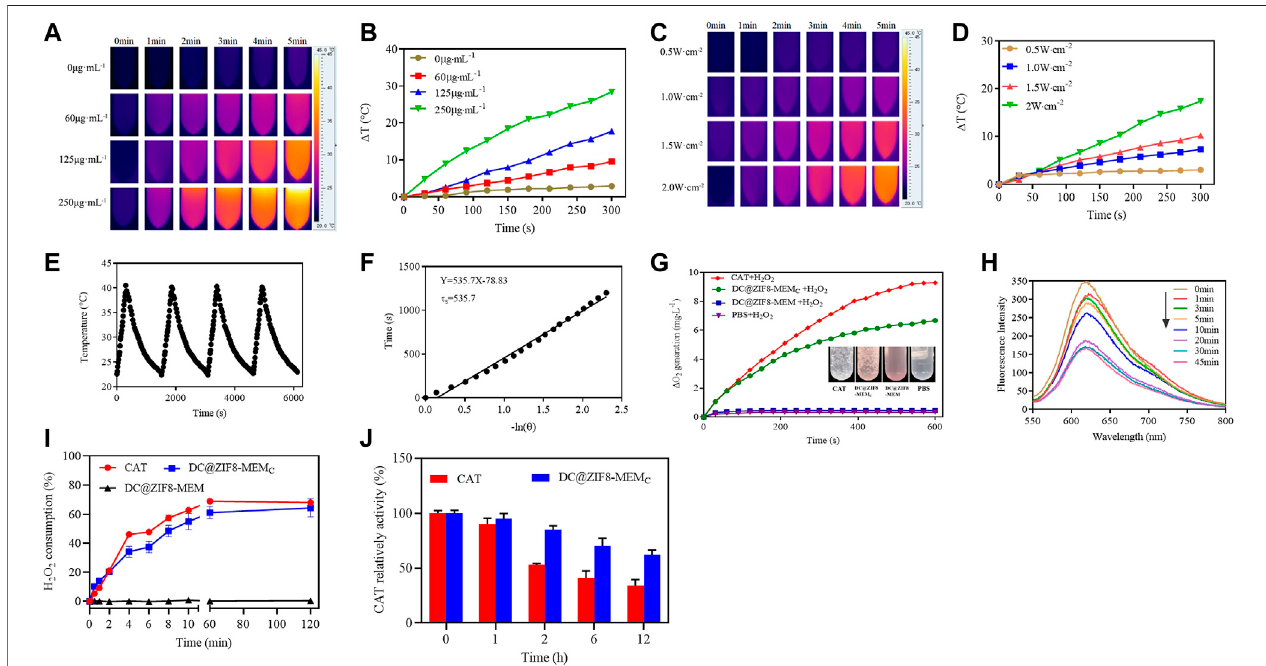
FIGURE3| PhotothermalimagesofDC@ZIF8-MEM C withvariousconcentrationsbyFLIR (A) .TemperaturecurvesbychangingconcentrationofDC@ZIF8-MEM C with808 nm nearinfrared (NIR) at 2 W · cm − 2 for5 min (B) .Photothermalimages ofDC@ZIF8-MEM C withvarious laserpower densities byFLIR (C) .Temperaturecurves ofDC@ZIF8-MEM C bychangingthelaserpowerdensity (D) .TemperaturevariationsofDC@ZIF8-MEM C byrepeatingon/off(2 W cm − 2 ) (E) .Temperature fi ttingcurveof DC@ZIF8-MEM C (F) . The O 2 -generating behavior of DC@ZIF8-MEM C , DC@ZIF8-MEM, PBS, and free CAT solution in the presence of H 2 O 2 . Inset is the corresponding image of these four solutions (G) . Fluorescence absorption curves of ruthenium (II) dichloride [Ru (DPP) 3 Cl 2 ] incubation with DC@ZIF8-MEM C (H) . The H 2 O 2 consumption kinetics of free catalase (CAT), DC@ZIF8-MEM C , and DC@ZIF8-MEM at 37 ° C (I) . The relative enzymatic activity of free CAT and DC@ZIF8-MEM C after treating with protease K for different incubation times (J)